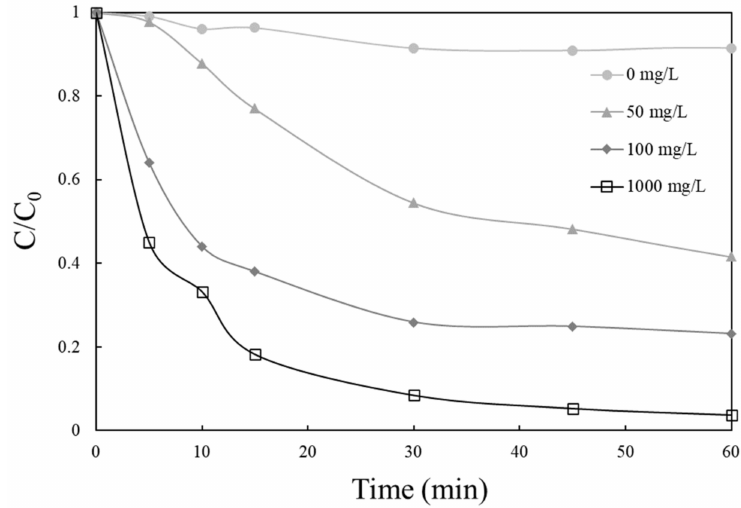
Figure 5. Effect of the catalyst concentration of 0.25 MoS 2 /BiOCl on the degradation of 0.5 mg/L VLS under simulated solar irradiation in UPW.